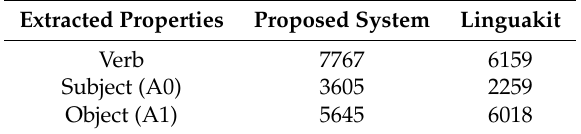
Figure 4. Precision, recall, and F1 measure of semantic role labeling on the validation set. Table 7 details the proposed system and the Linguakit-extracted properties, respectively, using Data set 1. Table 7. Data set 1: Proposed system versus Linguakit-extracted